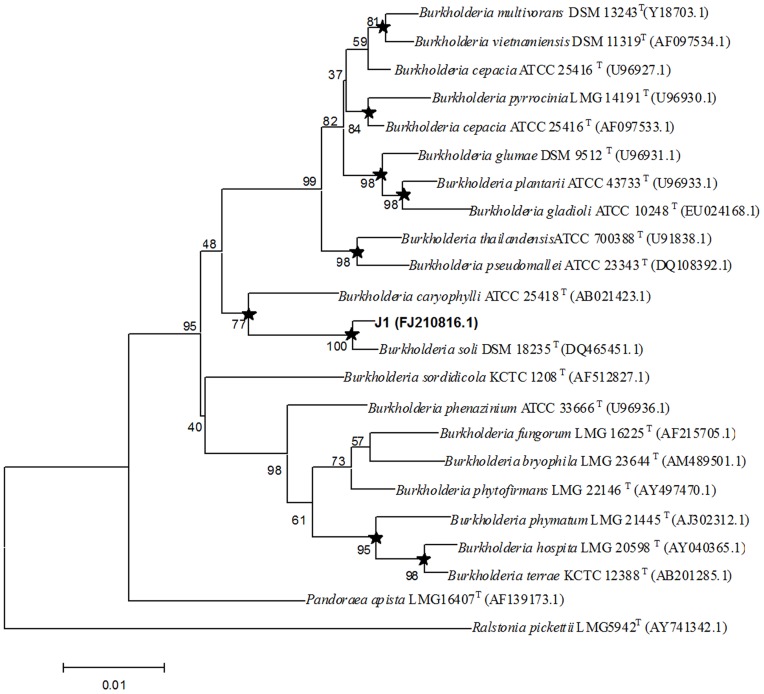
Unrooted Neighbour-joining tree constructed from Burkholderia 16S rRNA gene sequences, showing the phylogenetic relationship between Burkholderia dabaoshanensis sp. nov. and other Burkholeria spp.
Pandoraea apista LMG16407T and Ralstonia pickettii LMG5942T was used as the outgroup. Bootstrap values (expressed as percentages of 1000 replications) greater than 50% are given at the nodes. GenBank sequence accession numbers are given in parentheses. Bar,0.01 substitutions per nucleotide position. The Minimum Evolution and Maximum Parsimony methods were also used for tree construction. Branches marked with an asterisk are conserved in all methods used.